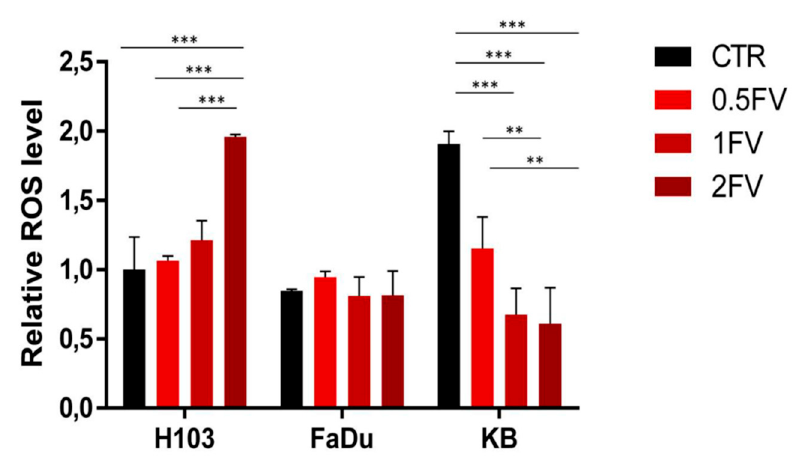
Figure 4. Impact of fucoidan on the synthesis of reactive oxygen species in HNSCC cells. Twenty-four hour treatment with fucoidan up-regulates ROS production in a dose-dependent manner in H103 cells, whilst down-regulating it in KB cells. No effect was observed on FaDu cells. (CTR—control, 0.5FV—half-fold of IC50 concentration, 1FV—IC50 concentration, 2FV—2-fold of IC50 concentration).